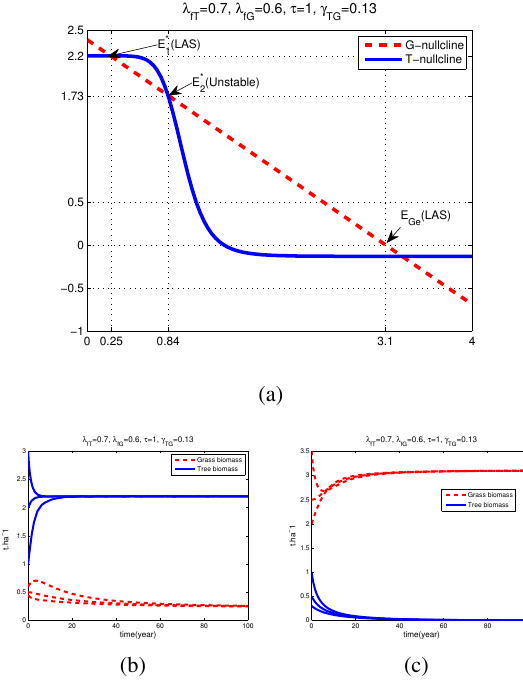
Fig. 14: (a) Bistability between E ∗ (3 . 1;0) . Up to the initial conditions, the system may reach: (b) E ∗